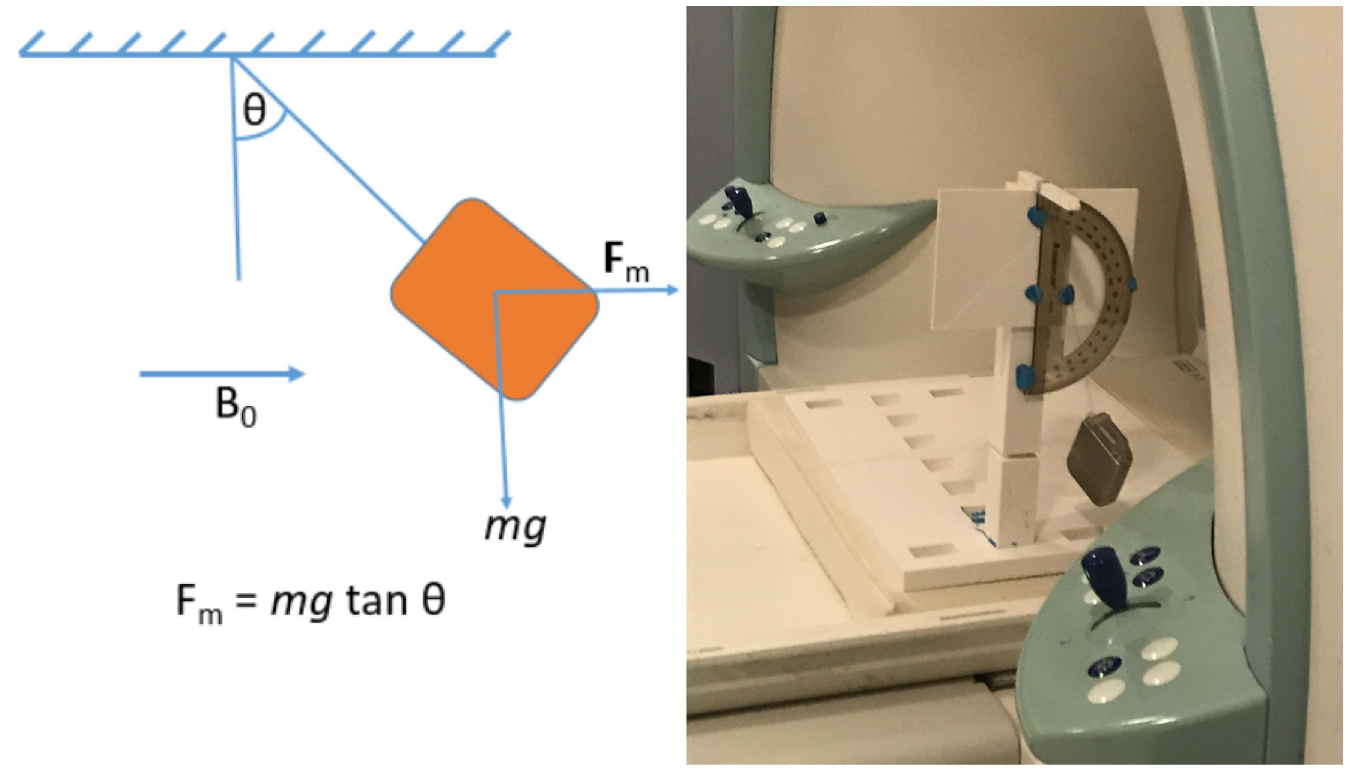
Fig 4. Force measurement